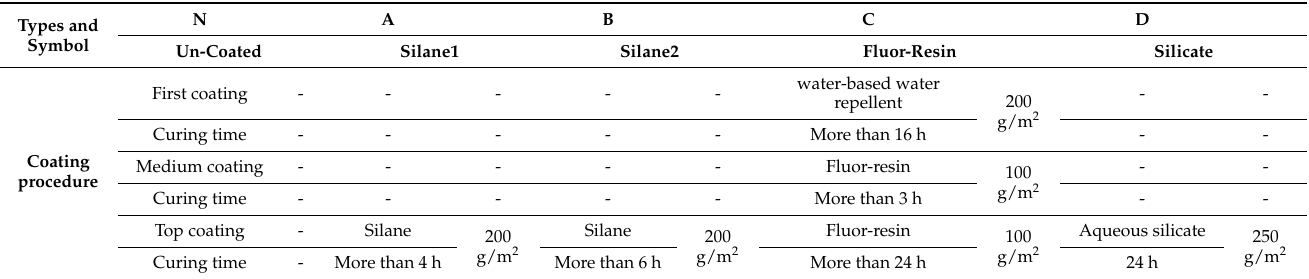
Table 2. Surface protective materials.